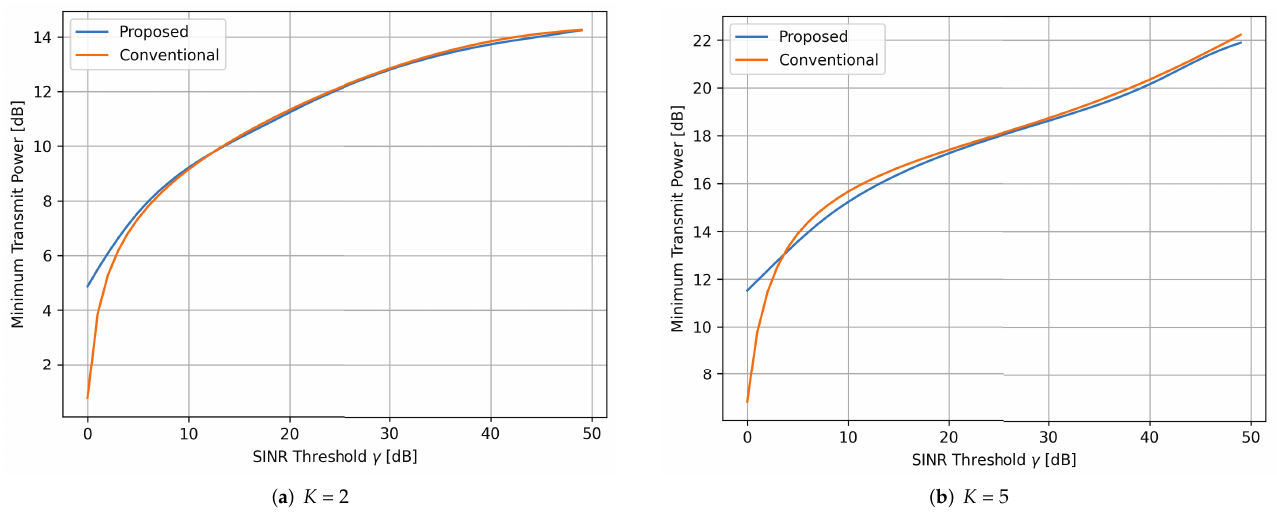
Figure 5. Minimum transmit power versus the SINR threshold for the downlink with v = 160 km/h.